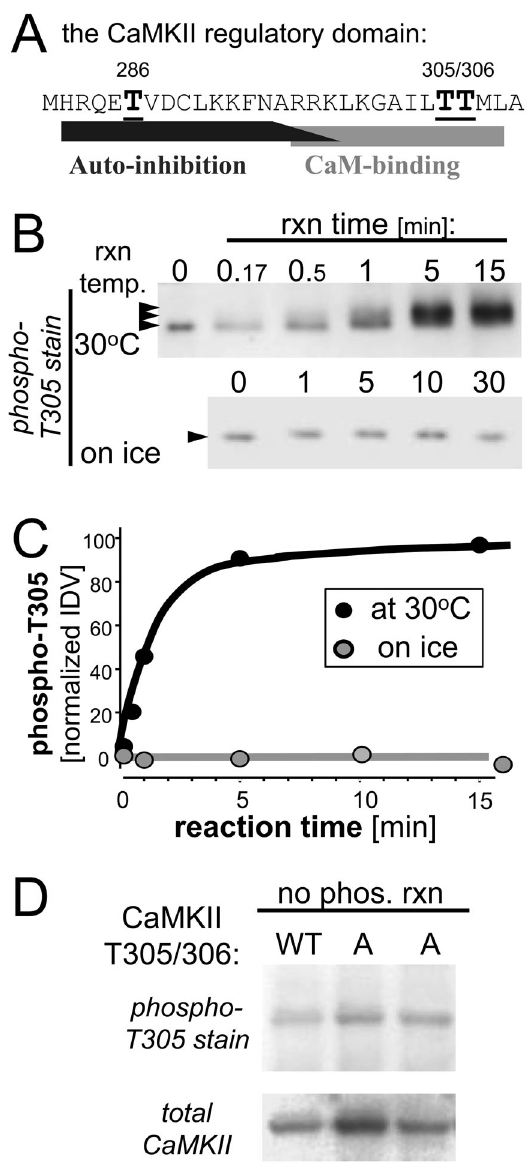
Figure 3. CaMKII T305/306 ‘‘burst’’ auto-phosphorylation in vitro . A , The sequence of the CaMKII regulatory domain with T286 in the autoinhibitory region and T305/306 in the CaM-binding region indicated. B , T305/306 phosphorylation was assessed by Western analysis. CaMKII was pre-phosphorylated at T286 on ice; the ‘‘burst’’ was induced by EGTA addition at 30 u C or on ice, and stopped after different reaction times. Note the band-shift caused by phosphorylation of additional sites during the ‘‘burst’’ at 30 u C, and the basal immuno- detection without phosphorylation reaction. C , Quantification of the relative T305/306 phosphorylation during the ‘‘burst’’ by arbitrary relative immuno-detection values (IDV). Basal immuno-detection prior to the phosphorylation reactions was subtracted in the quantification shown. No increase in phosphorylation was detected on ice. For 30 u C, the results indicate an initial phosphorylation rate (at reaction times of 1 min or less) of , 0.45 min 2 1 (assuming that saturation represents near-complete phosphorylation; otherwise the rate is even lower). D , The basal immuno-detection with the phospho-T305 antibody prior to the phosphorylation reactions was likely due to background immuno- reactivity, as indicated by comparison to T305/306A mutant CaMKII.